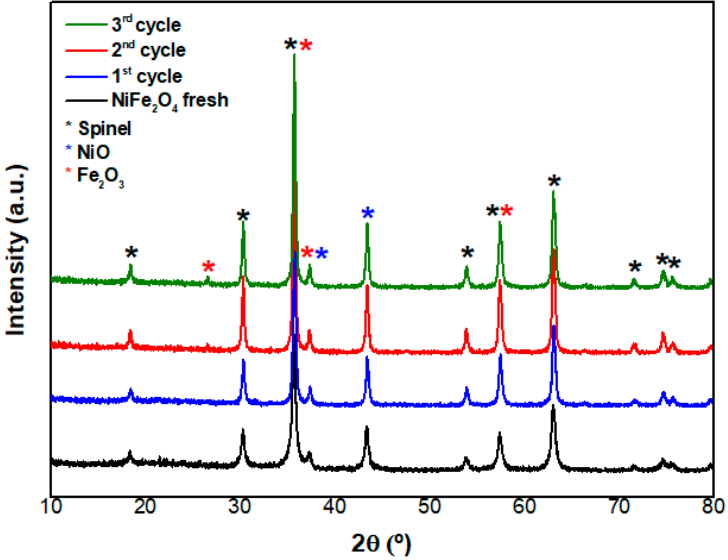
Figure 10. XRD patterns of fresh and recycled NiFe 2 O 4 catalysts. Table 3. Semi-quantitative composition* and NiFe 2 O 4 crystallite size of fresh and recycled catalysts.